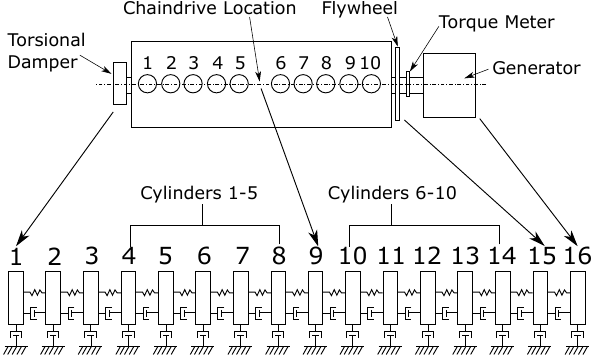
Figure 2. Crankshaft dynamics lumped mass model schematic